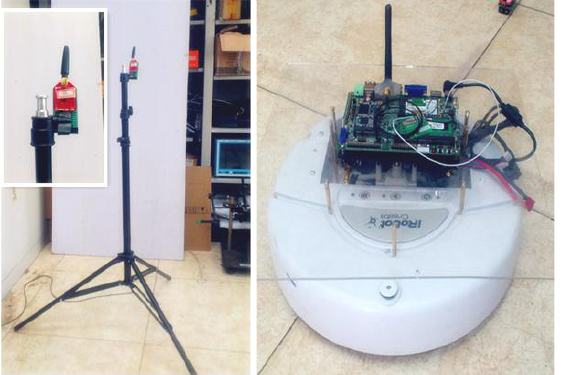
Figure 2. ZigBee nodes